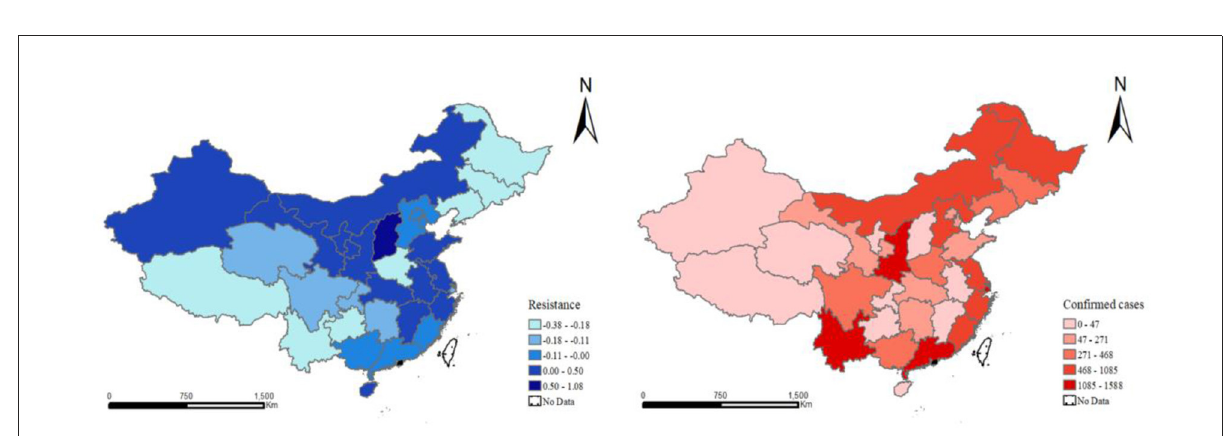
FIGURE2 Regional economic resistance and geographic distribution of confirmed cases in provinces of China during COVID-19 in 2021.